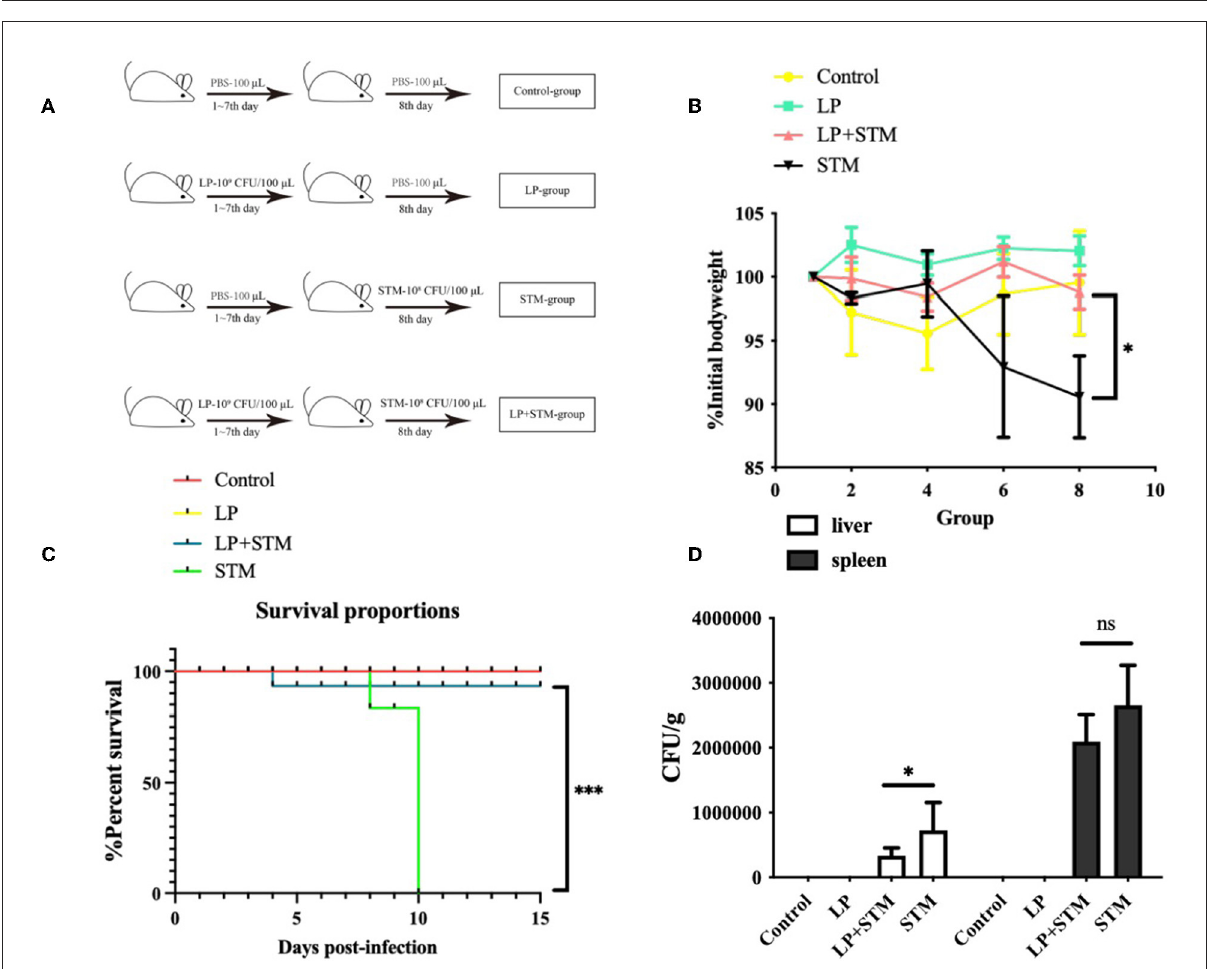
FIGURE4 Lactobacillus plantarum pre-administration enhanced the protective effect in vivo of mice against STM. C57BL/6 mice were divided into four groups: LP, STM, LP + STM, and Control. LP, LP ( ∼ 10 9 CFU/100 µ l) was intragastrically administered for 7 days; STM, STM ( ∼ 10 8 CFU/100 µ l) was orally administered on day 8; LP + STM, mice were orally infected with LP for 7 days and infected with STM; for the Control, LP was replaced with PBS. (A) Mice grouping diagram. (B) Identification of body weight loss after infection for over 10 days with STM. (C) Mice survival rate was recorded 15 days after being infected with STM. (D) STM loads in spleen and liver. No STM colonies were observed in the liver or spleen of mice in the LP and Control groups. Results are presented as means ± SD (data were analyzed using survival analysis and unpaired t-test. ns not significant, * p < 0.05 , ** p < 0.01 , *** p <